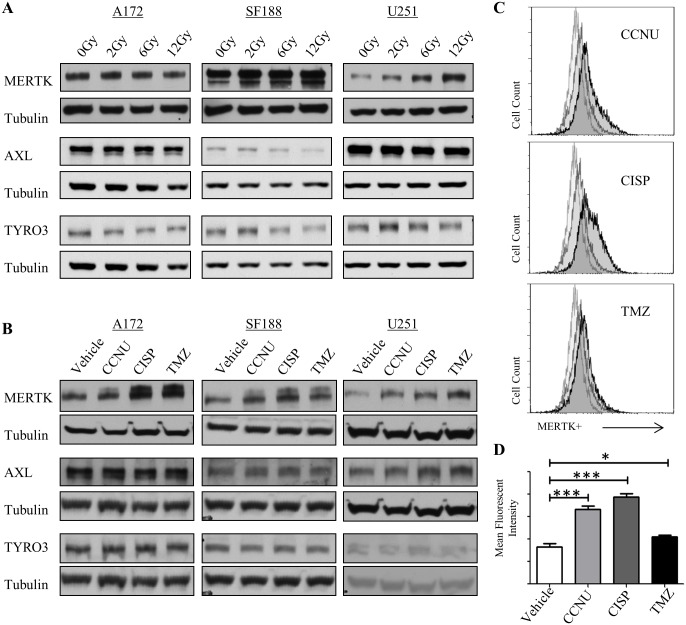
MerTK expression is increased in GBM cells after treatment with radiation and chemotherapy.A172, SF188, and U251 cells were exposed to 50uM lomustine (CCNU), 25uM Cisplatin (CISP), or 250uM Temozolomide (TMZ) (A) or radiation (0Gy, 2Gy, 6Gy, 12Gy) (B) for 48 hours and MERTK, AXL, TYRO3 and tubulin were detected in cell lysates by immunoblot. Representative images from three independent experiments are shown. (C-D) SF188 cells were treated with 50uM lomustine (CCNU), 25uM Cisplatin (CISP), or 250uM Temozolomide (TMZ) as described above and MERTK expression was determined by flow cytometry (colors on the flow cytometry graph; light grey = secondary only; grey = control; black = treatment). Representative images (C) and mean fluorescence intensities (+/- standard error) (D) from 2–4 independent experiments are shown. (* p<0.5, ** p<0.01, *** p<0.001, 1-sided ANOVA).